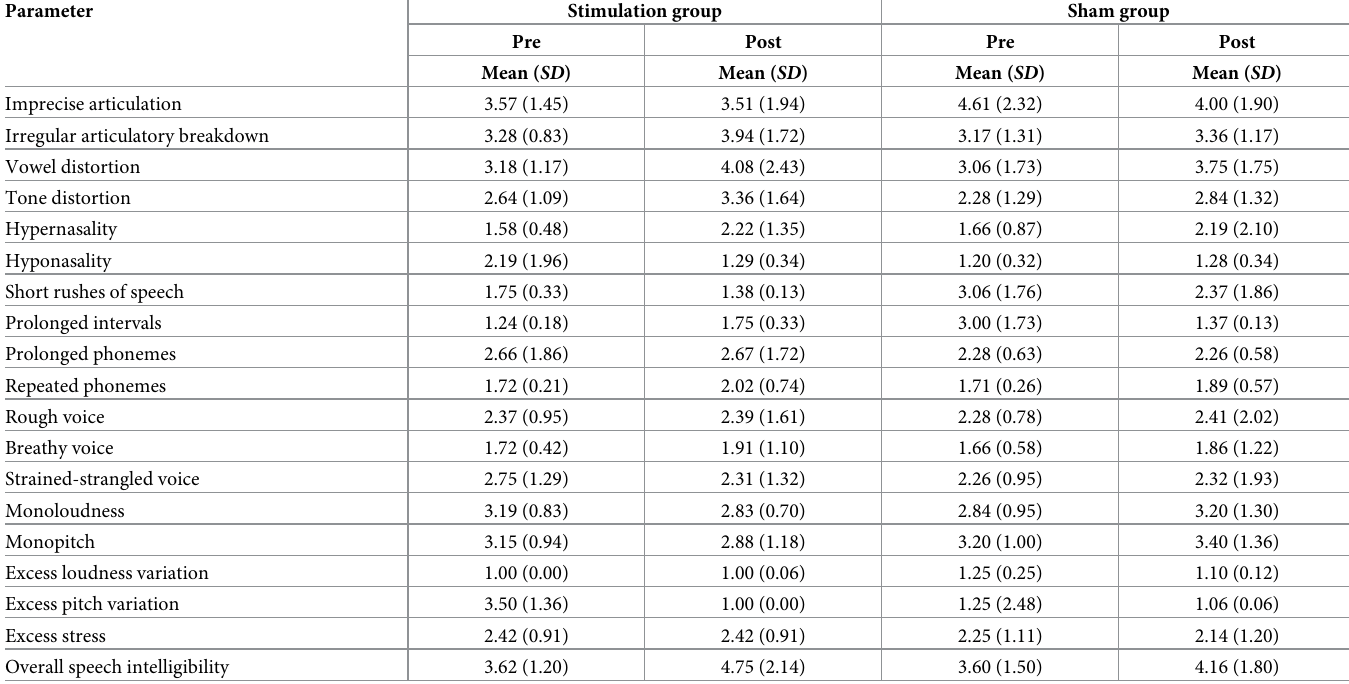
Table 3. Mean (and standard deviation) of the nineteen parameters measured in the perceptual evaluation of passage reading for the stimulation and sham groups before and after